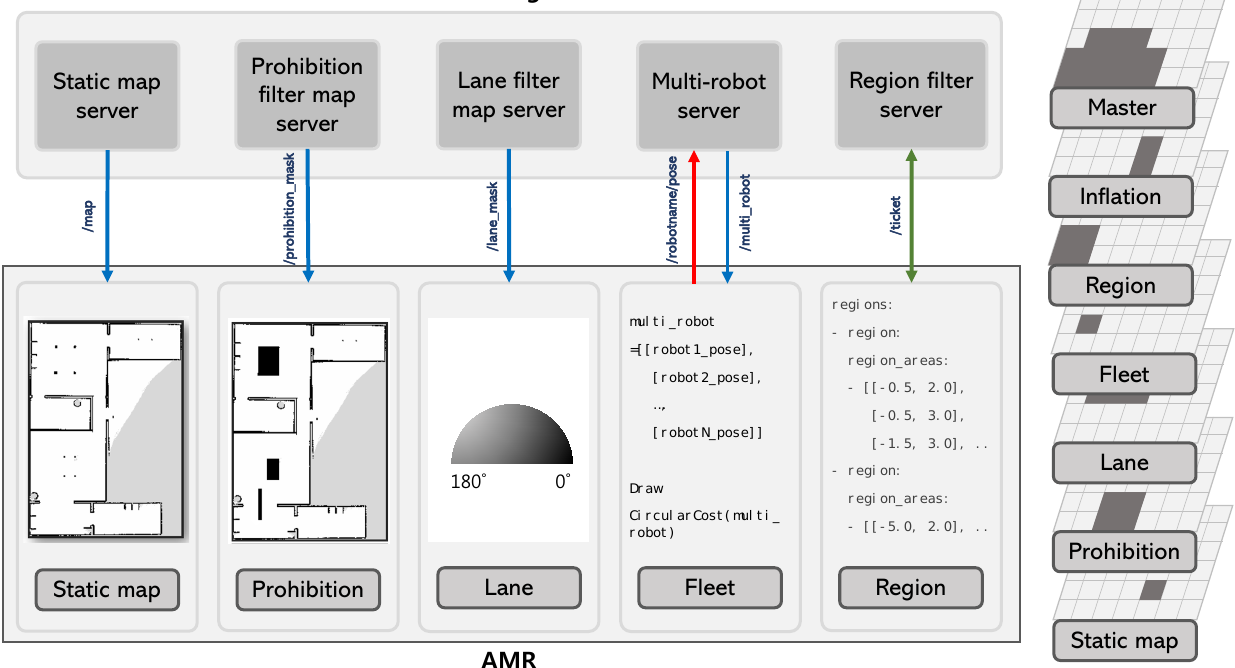
Figure 2. Layered cost map: the prohibition filter, lane filter, fleet layer, and region